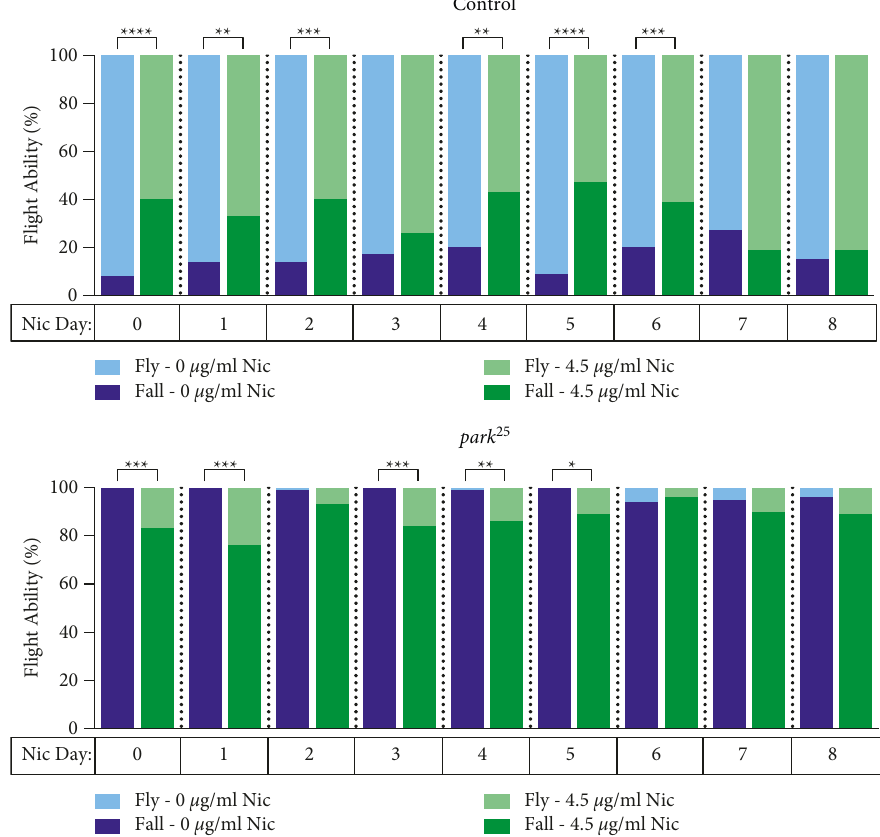
Figure 5: Nicotine (4.5 μ g/mL) improves flight performance in homozygous park 25 flies when given on days 0–5 post-eclosion. Control flies and park 25 mutants were initiated with 4.5 μ g/mL nicotine on different starting days (days 0–8) post-eclosion. On day 20, flies were tested for their ability to fly. Results from individual Fisher’s Exact Tests between the control and park 25 flies at each nicotine concentration are shown. ∗∗∗∗ � P < 0 . 0001, ∗∗∗ � P < 0 . 001, ∗∗ � P < 0 . 01 ∗ � P < 0 . 05. The results of each data point are from at least five separate experiments with an n ≥ 36 flies (see Supplemental Table 1 for